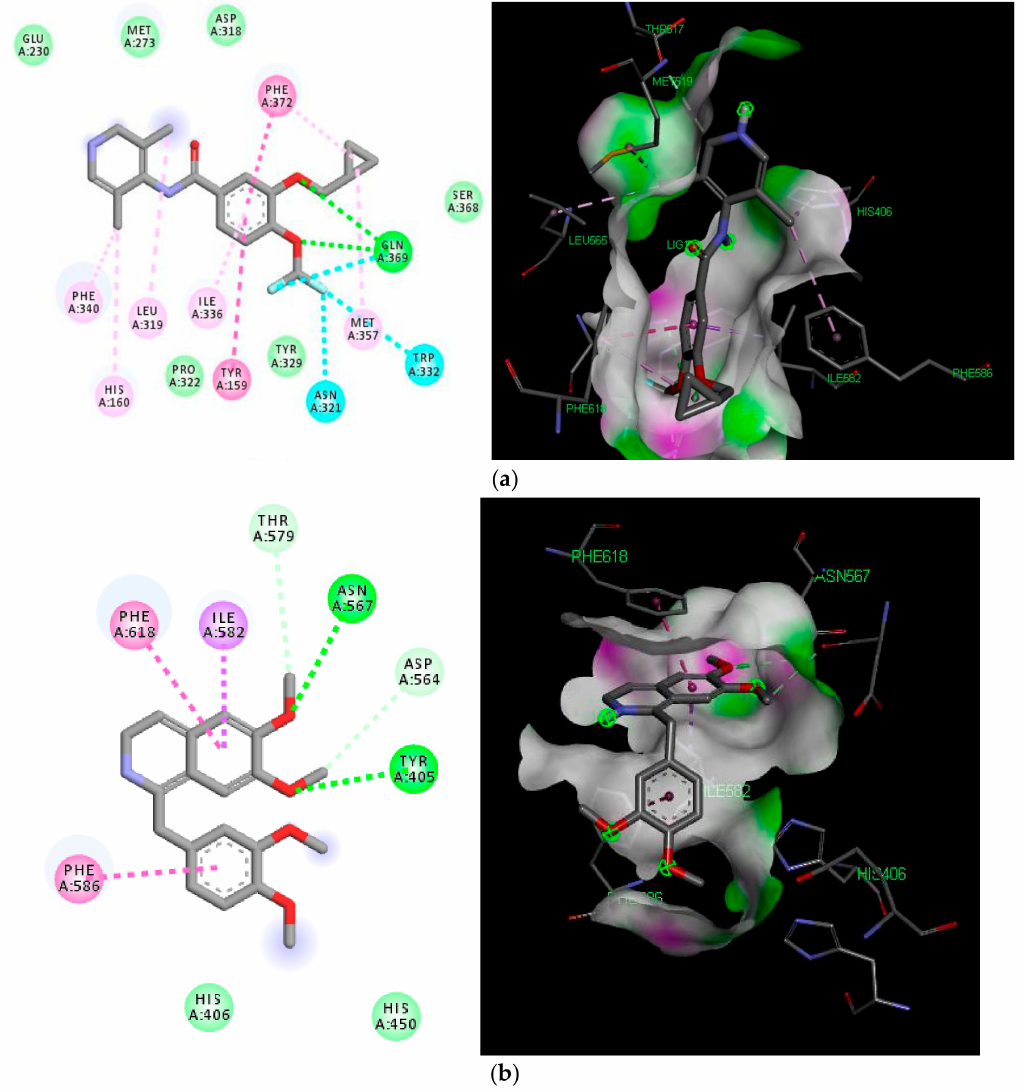
Figure 5. ( A ) 2D and 3D diagrams of the docked structure of roflumilast in the active domain of PDE-4 (5LAQ). ( B ) . 2D and 3D diagrams of the docked structure of papaverine in the active domain of PDE-4 (5LAQ). Green dashed lines represent hydrogen bonding, cyan lines represent halogen bonding, light purple lines represent Sigma–Pi